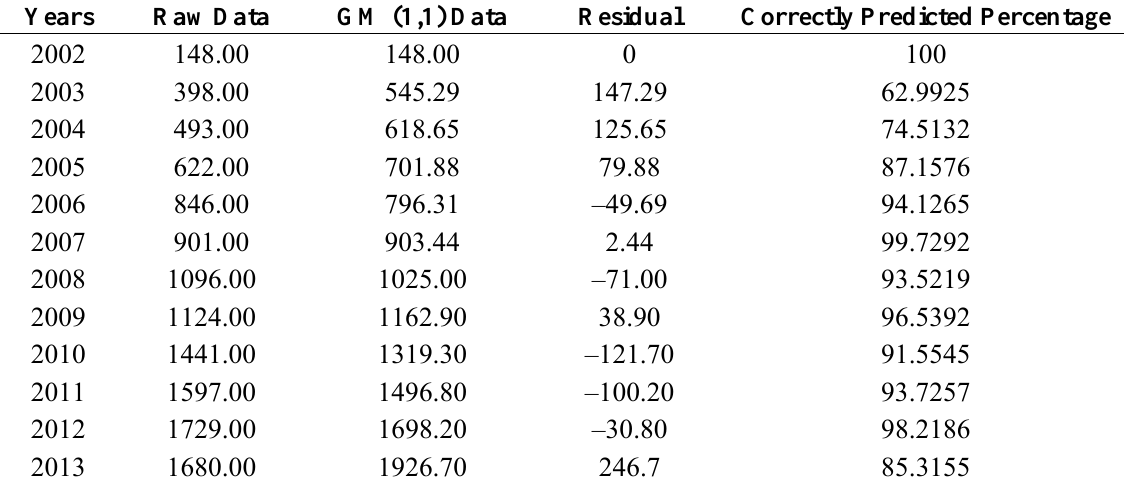
Table 2. Forecast data using the grey model GM